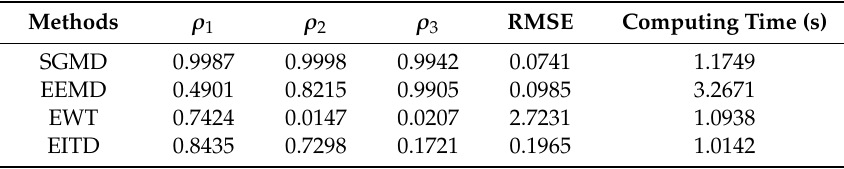
Table 1. Decomposition index comparison among di ff erent